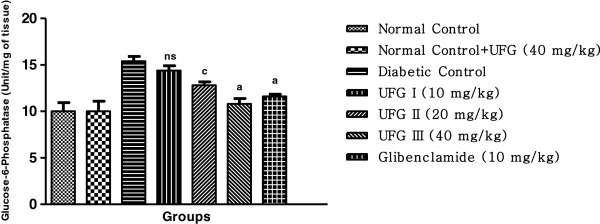
Effect of umbelliferone β-D-galactopyranoside on level of Glucose-6-phosphatase at different concentrations on STZ induced diabetic rats, compared to diabetic control group rats; values are mean ± SEM; n = 6;
c
P < 0.05;
b
P < 0.01;
a
P < 0.001; P > 0.05 is considered as non-significant (ns).